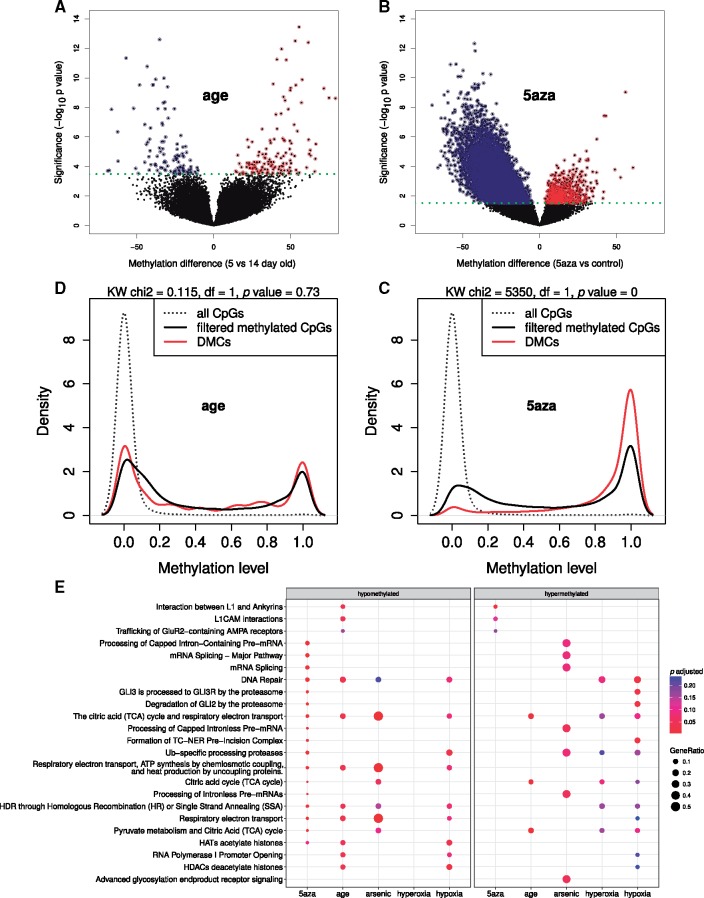
—Extrinsic and intrinsic induced differentially methylated CpGs (DMCs) in D. magna Bham2. (A) Volcano plot of DMCs in age comparison. Methylation difference is the percentage change in methylation level in 5- to 14-day-old D. magna Bham2 (blue = hypomethylated and red = hypermethylated in 5-day-old compared to 14-day-old samples). (B) Volcano plot of DMCs in 5aza-treatment. (C) Density plot of the DMCs in 5aza-treatment. Majority of the affected CpGs have high methylation level in control samples (red) compared to the unaffected CpGs (black). (D) Density plot of the DMCs in ageing (red). The methylation level of affected CpGs is the same as the background set of filtered CpGs (black). Both sets are enriched for higher methylation compared to the unfiltered CpGs (dashed line). (E) Enrichment analysis of DMCs across the conditions. The analysis is carried out separately for genes containing hyper- and hypo-methylated CpGs.